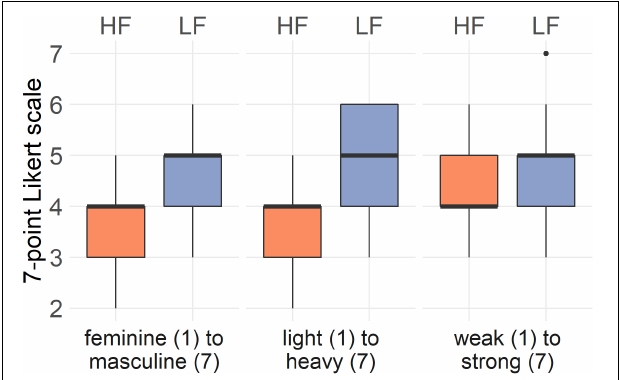
FIGURE 3 | Answers of the women ( n = 25) to the bodily feelings questions on perceived masculinity and femininity, body weight, and strength in the high frequency and low frequency condition. Black horizontal line shows median score; lower and upper hinge correspond to the first and third quartiles (25th and 75th percentiles).